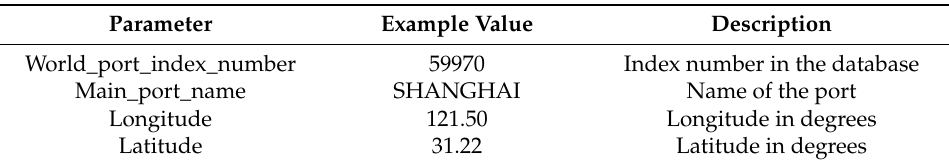
Table 2. Primary parameters in World Port Index.